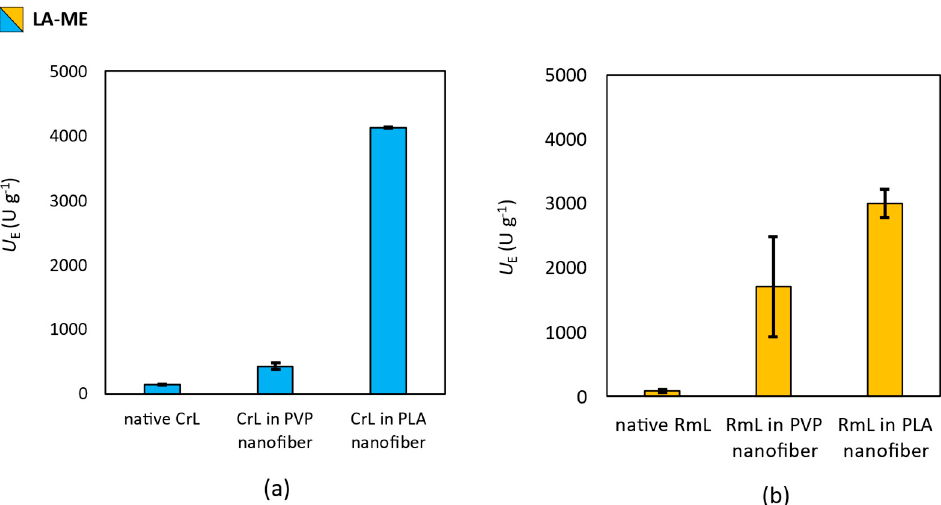
Figure 7. Investigation of the effect of entrapment by electrospinning into PVP and PLA nanofibers on the biocatalytic activity of ( a ) Candida rugosa (CrL) and ( b ) Rhizomucor miehei (RmL) lipases in the biocatalyzed hydrolysis of methyl linoleate ( LA-ME ). Test reactions were carried out at 33 °C under constant shaking. This figure summarizes the specific enzyme activity values obtained by gas chro- matography of samples taken 2 h after the start of the reactions. Activity values were determined by the following equation: U E = n s × c × ( t × m E ) − 1 , where c is the conversion (%) n S is the amount of substrate [ μ mol], t is the time [min], and m E is the mass of enzyme [g]. Regarding the lipase catalyzed hydrolysis of oleic acid methyl ester ( OA-ME ), results were similar to PA-ME , the remarkably positive effect of nanofibrous formulation was clearly seen on U E values. The difference between PVP and PLA matrices and the two